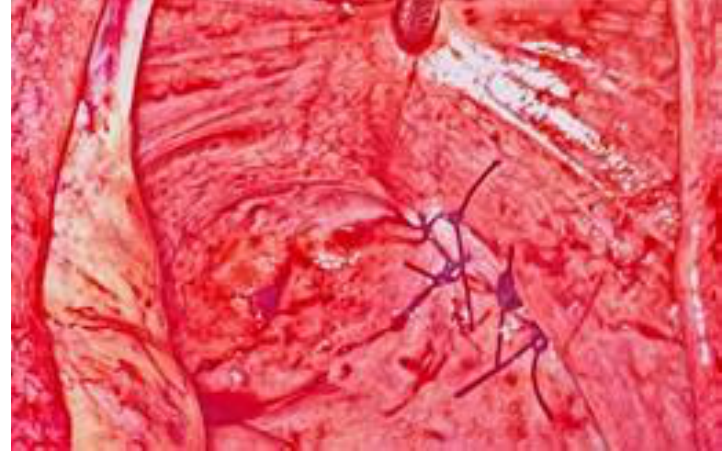
Figure 4. Laparoscopic repair using 0 Vicryl detached stitch suture.